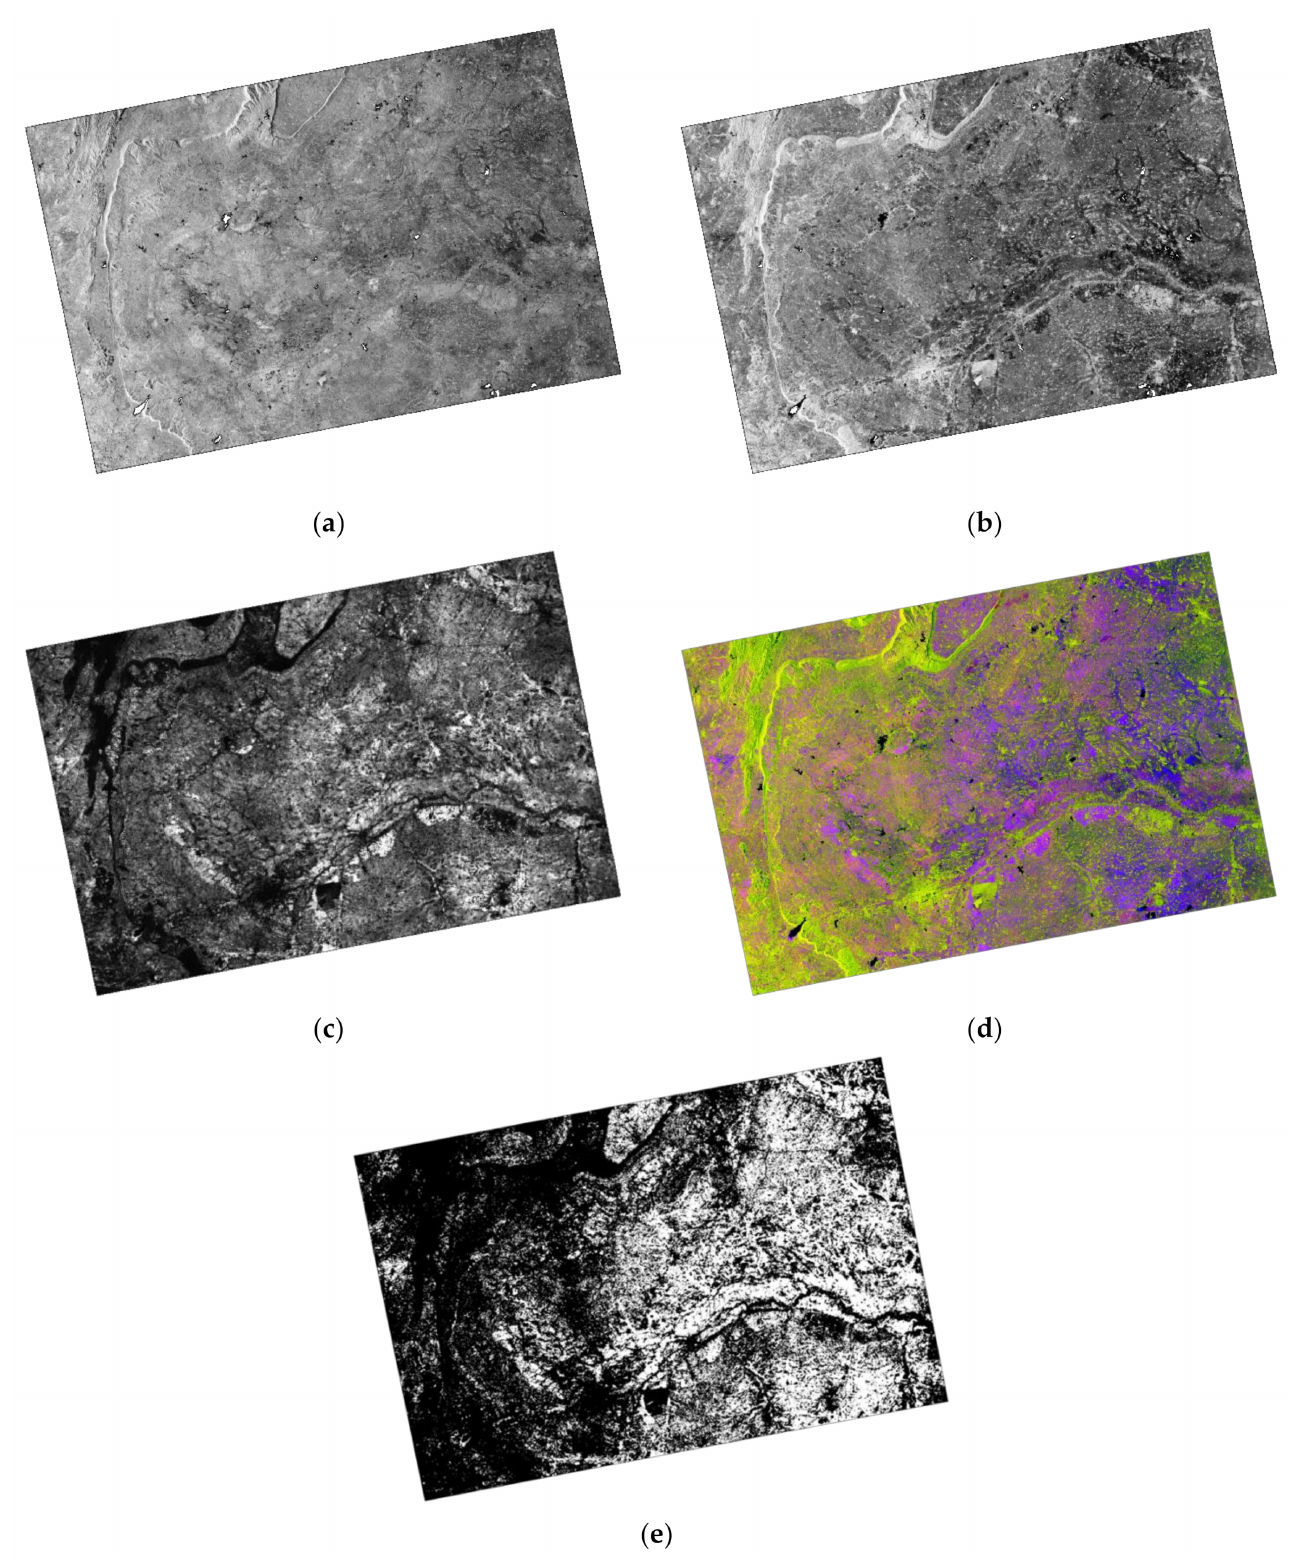
Figure 9. Temporal features of time-series VH polarization of frame 99-16: ( a ) σ 0 max ; ( b ) σ 0 (R: σ 0 max , G: σ 0 , B: σ 0 var ); ( e ) label image of frame 99-16, where bright pixels indicate paddy min